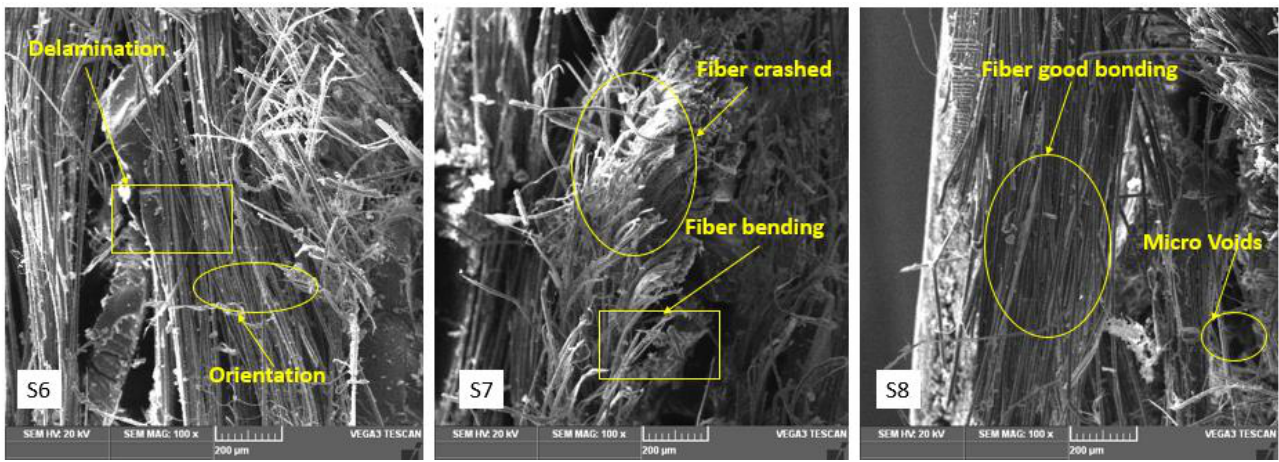
Figure 15. SEM images of S6, S7 and S8 flexural fracture composites